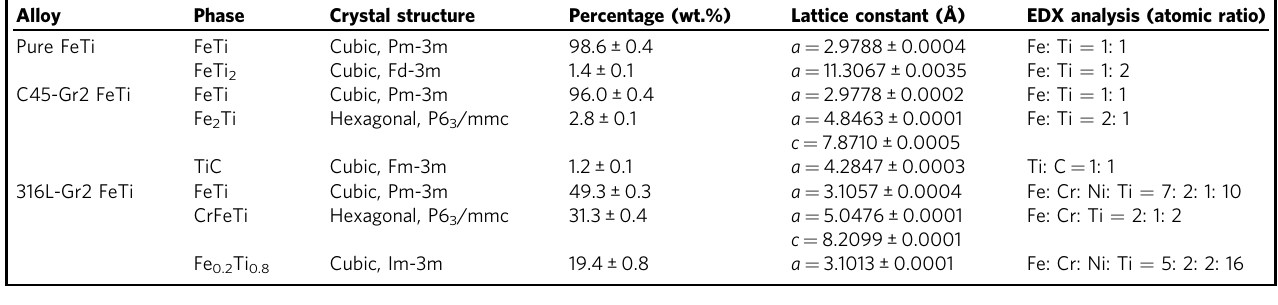
Table 1 Phase constitutions of pure FeTi, C45-Gr2 FeTi, and 316L-Gr2 FeTi alloys. Alloy